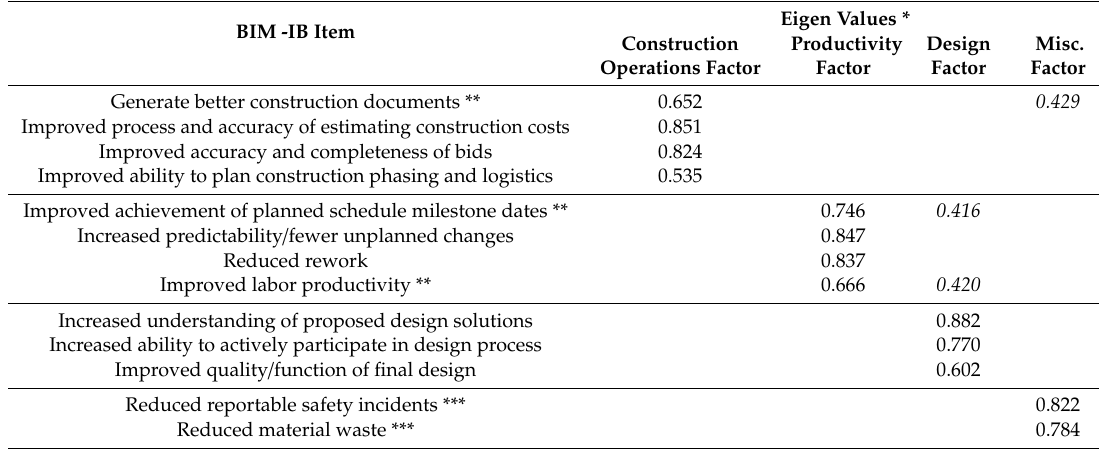
Table 3. Exploratory Factor Analysis: BIM Implementation Benefits.